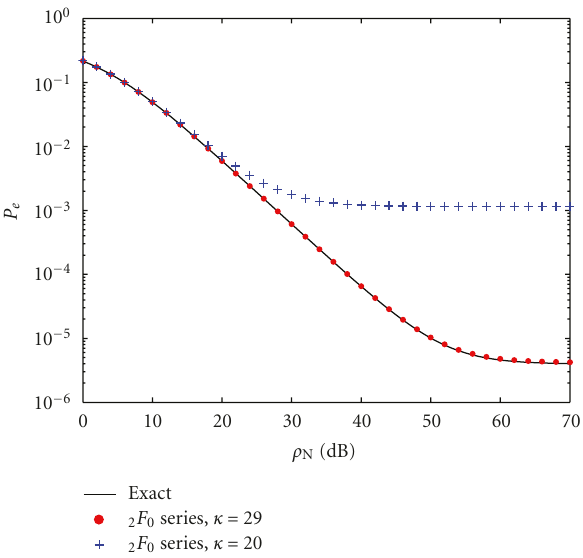
Figure 4: E ff ect of the truncation error ( ρ I = 13 dB). For T = 3 ( T = 6), our criterion produces κ = 20 ( κ = 29). The exact curve is obtained by using κ = 101. In all three cases, k min =